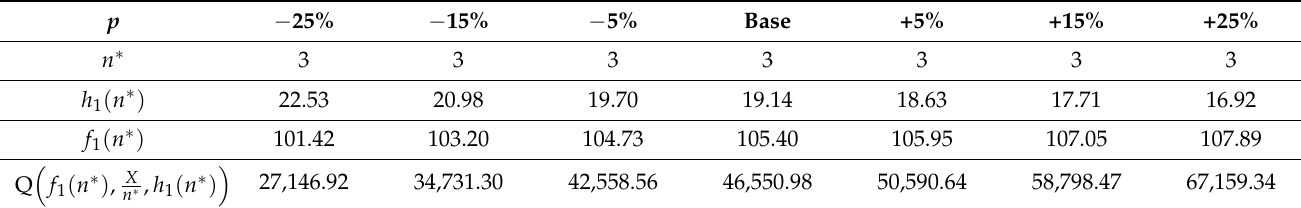
Table 9. Variation of the trip density by all modes p